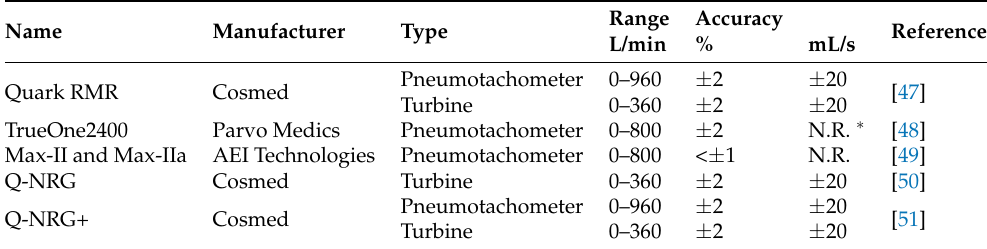
Table 3. Overview of the technical specifications (measurement range and accuracy) of turbine flow meters and Pneumotachometers of commercial indirect calorimeters as reported by the